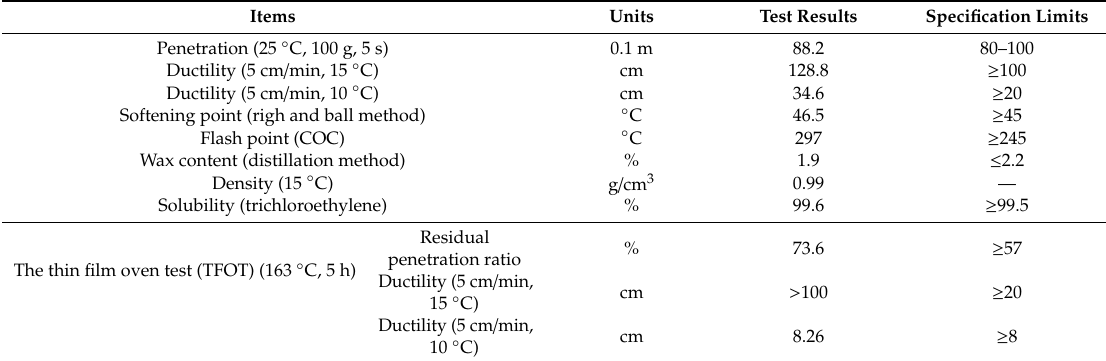
Table 1. Virgin asphalt binder